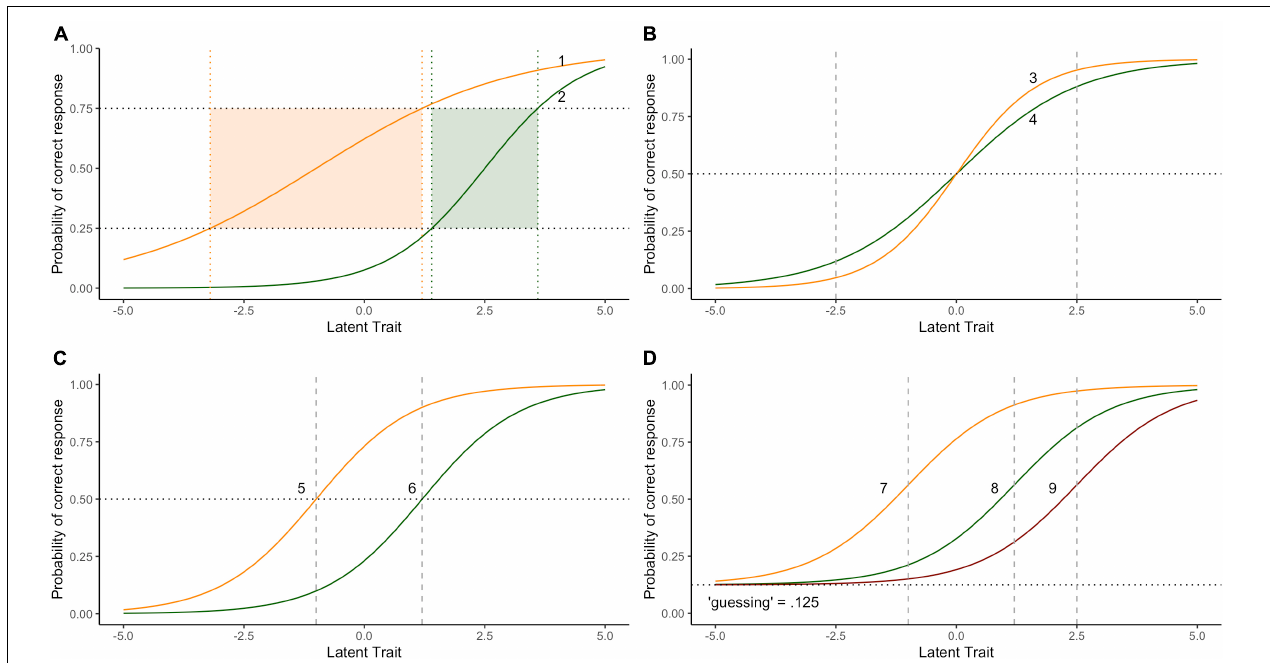
FIGURE 1 | Item response functions reflecting different models (A) differential item discrimination with non-overlapping curves, (B) differential item discrimination with overlapping curves, (C) constant item differentiation, (D) constant differentiation and adjustment for